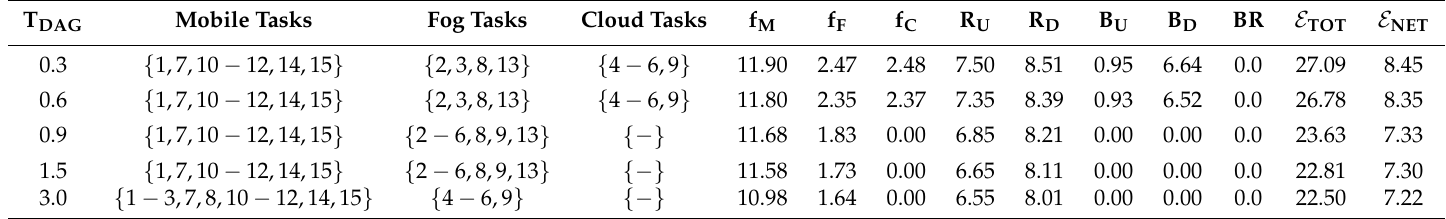
Table 7. Task, resource allocation, and energy consumption returned by GeneticTA_par under DAG2. Resources are measured in Mbit/s and energies in Joule. T DAG